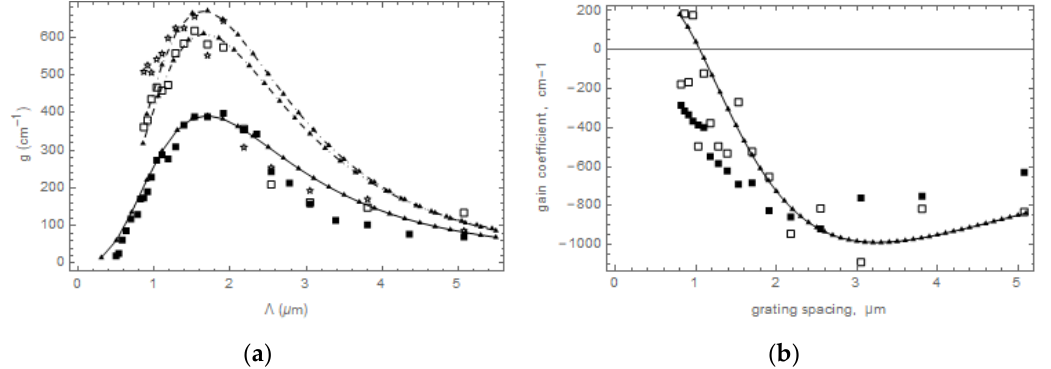
Figure 1. Typical dependence of the signal beam gain coefficient on the grating spacing in hybrid organic-inorganic cells with LC. ( a ) nematic LC, g is the gain coefficient, Λ is the grating spacing; theoretical fit for the gain coefficient (solid and dashed lines) to experimental data for nematic LC TL205 cells of di ff erent thickness: L ( µ m) = 5.7—stars, 7.1—light boxes, 10—black boxes [12]; ( b ) cholesteric LC mixture BL038 / CB15, theoretical results – curve, experimental data—boxes, the cell thickness L = 5 µ m [14].